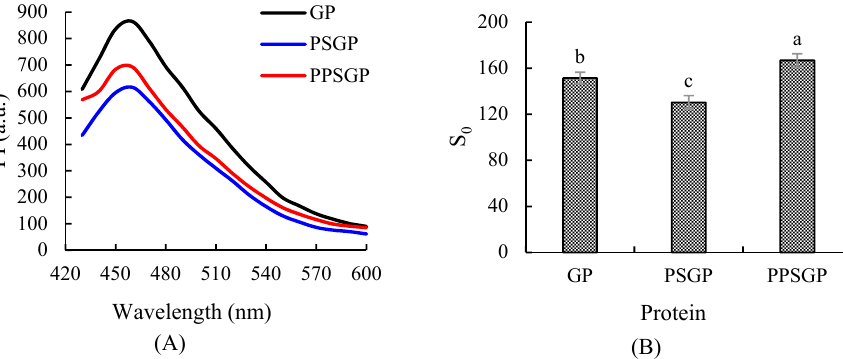
Figure 2. Fluorescence spectroscopy of GP isolate for surface hydrophobicity and an index of protein hydrophobicity (S 0 ). ( A ) represented surface hydrophobicity; ( B ) represented S 0 . Different letters indicate significant